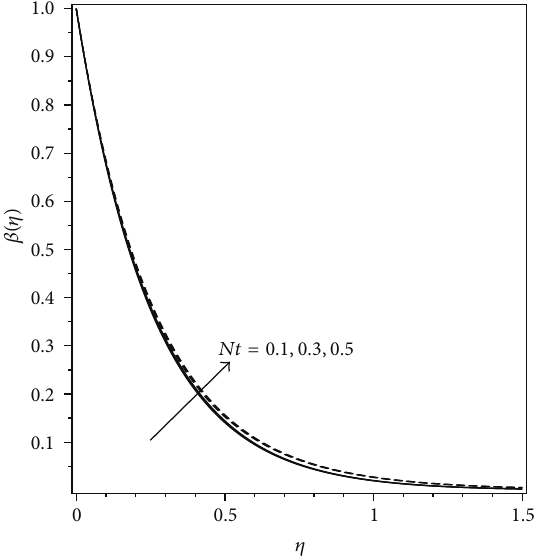
Figure 11: Concentration profiles for different values of Nt when Nb = 0.5, Le = 2, Pr = 6.8, 𝛾 = 0.1, 𝜎 = − 0.1, and S = 2. Conflict of